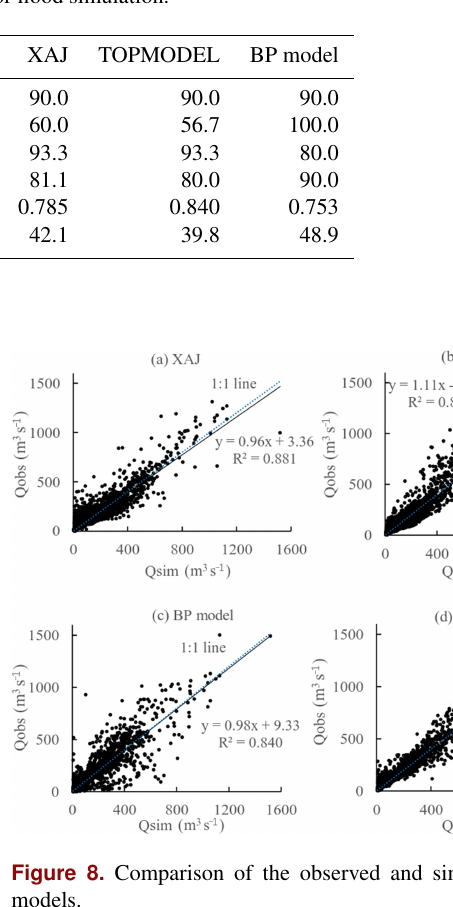
Figure 6. Topographic index calculation process. Table 3. Comparison of results derived by single hydrological model for flood simulation.